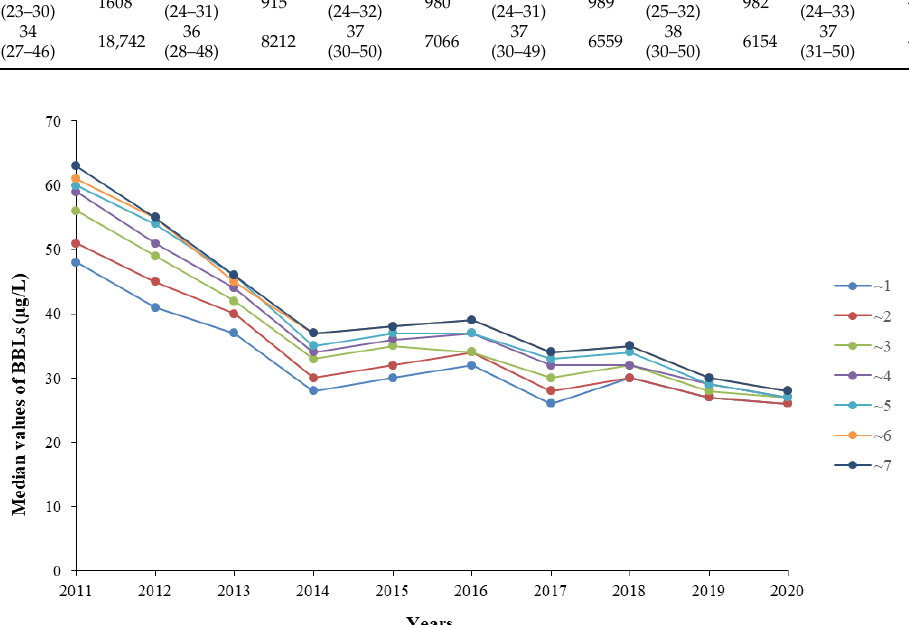
Figure 1. Changes in the median BLL of different age groups from 2011 to 2020. The seven colors represent seven age groups. Blue represents ~1 year group; Red represents ~2 years group; Green represents ~3 years group; Purple represents ~4 years group; Light blue represents ~5 years group; Orange represents ~6 years group; Navy blue represents ~7 years group.